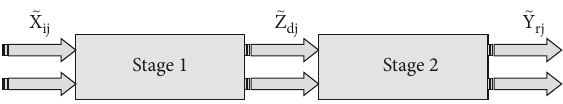
Figure 3: Two-stage model of the numerical Table 1: Trapezoidal intuitionistic fuzzy inputs for the first stage of the 12 DMUs.